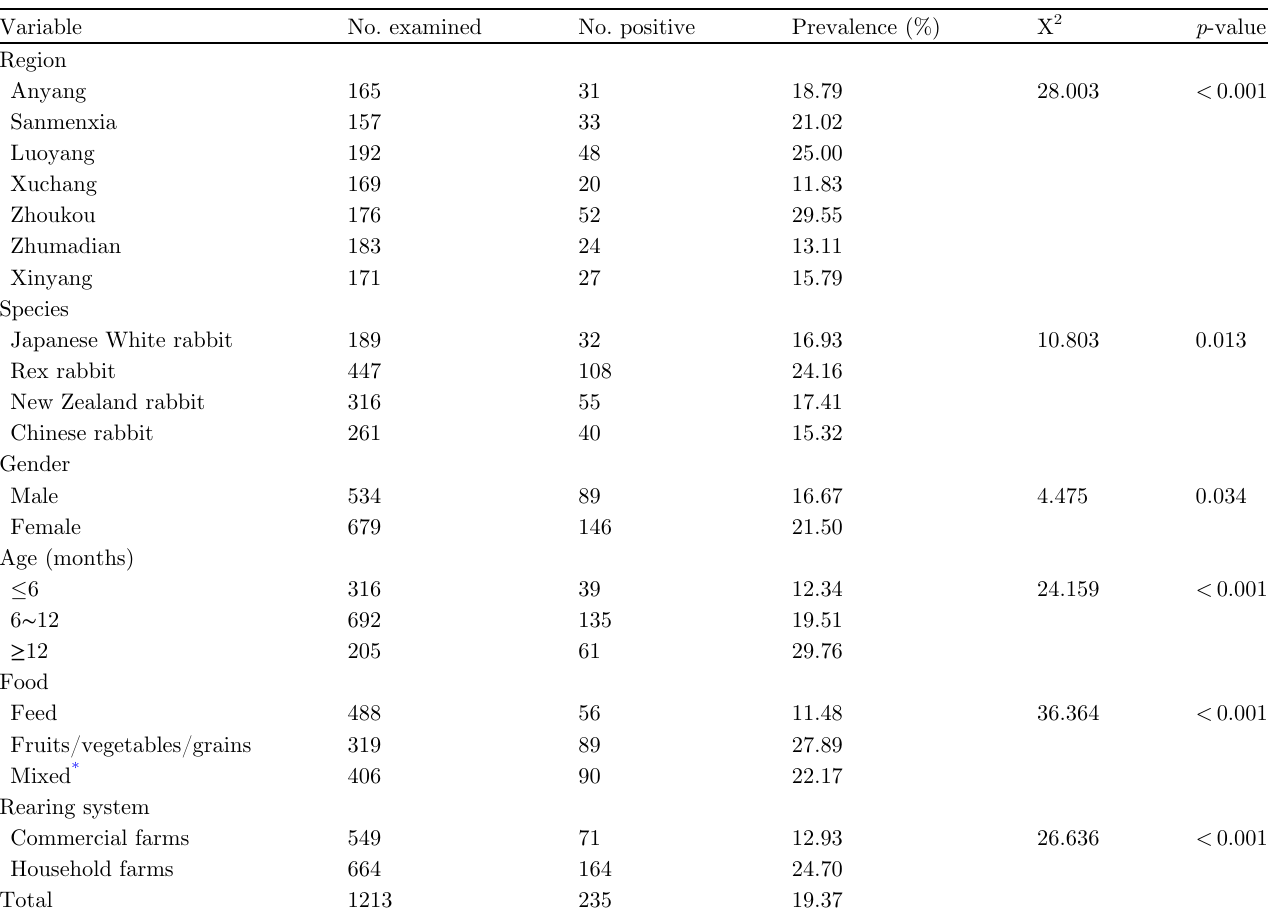
Table 2. Seroprevalence of E. cuniculi infection in domestic rabbits in Henan province, central